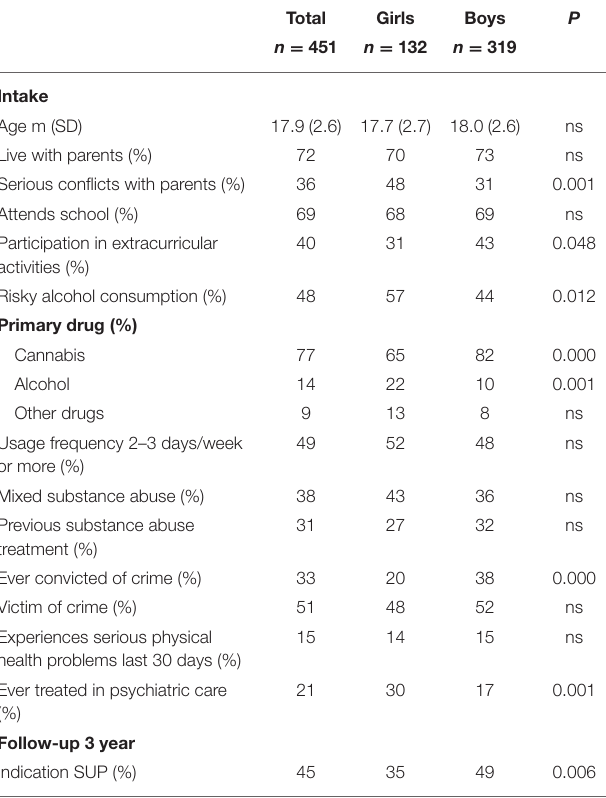
TABLE 1 | Descriptive variables at treatment intake and indication of substance use problems at 3-year